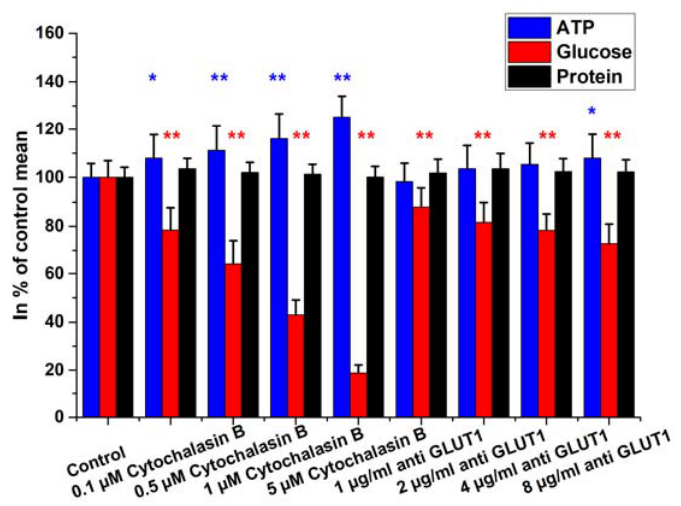
Figure 8. Intracellular glucose, ATP, and protein contents of HepG2 cells treated with cytochalasin B and anti-GLUT1 antibody (4 h incubation). Data are expressed as % of control. Bars represent mean ± SD of six independent experiments (* p < 0.05, ** p < 0.01 compared with controls).